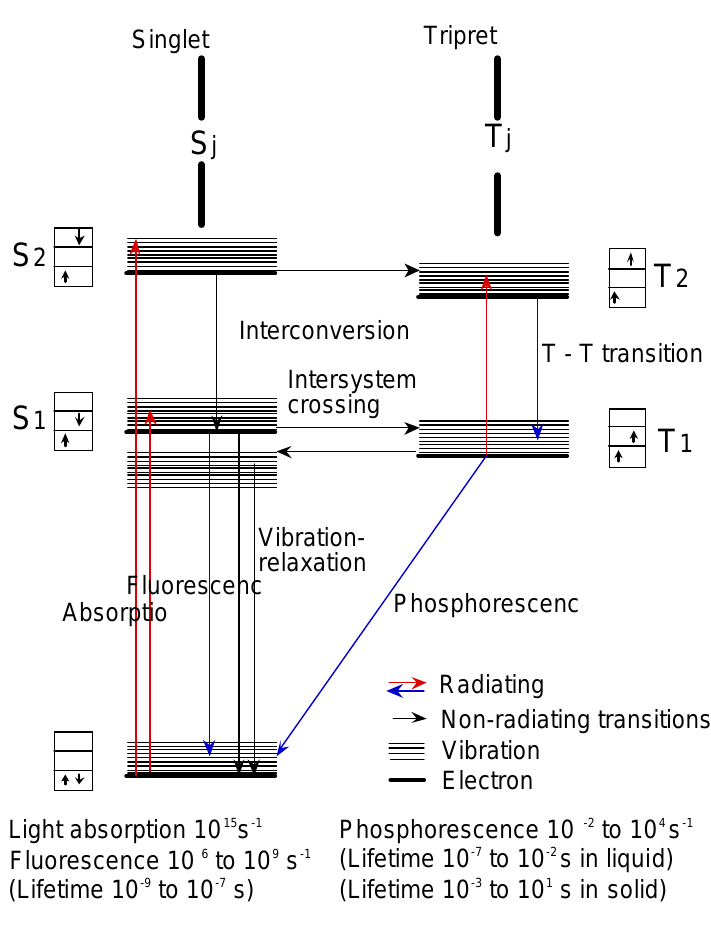
Figure 14. Jablonski